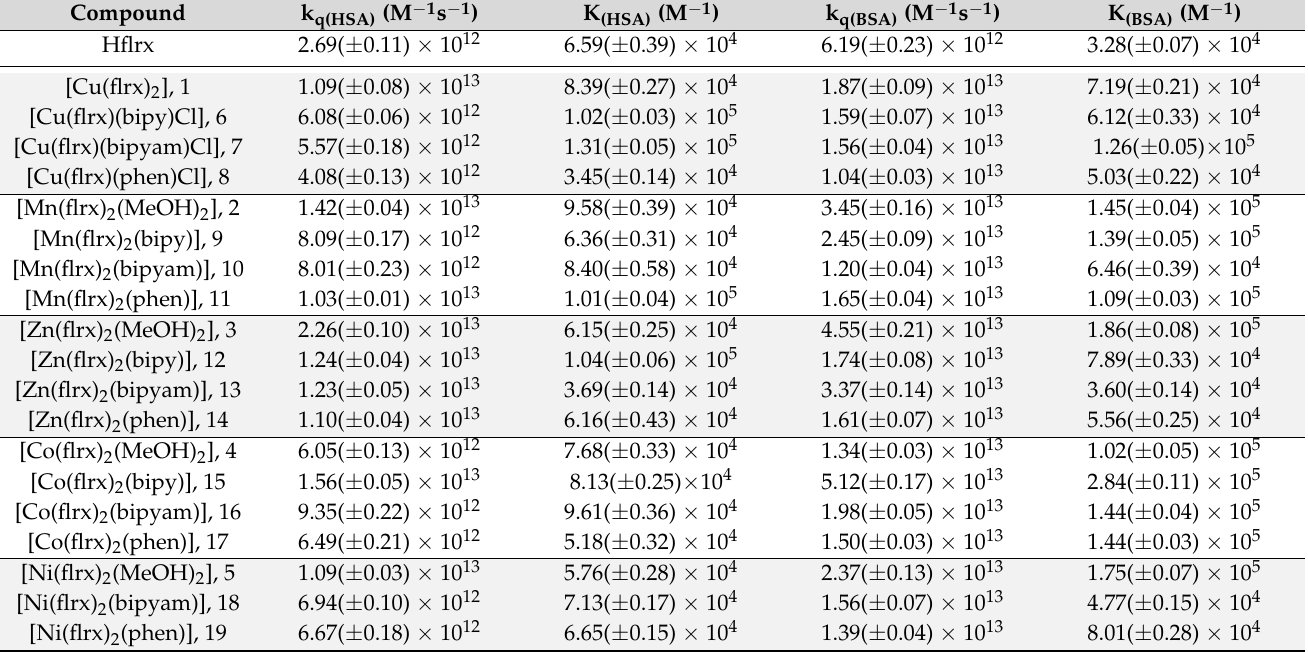
Table 5. The (HSA-/BSA-) quenching (k q ) and (HSA-/BSA-) binding constants (K) for fleroxacin and its complexes 1 – 19